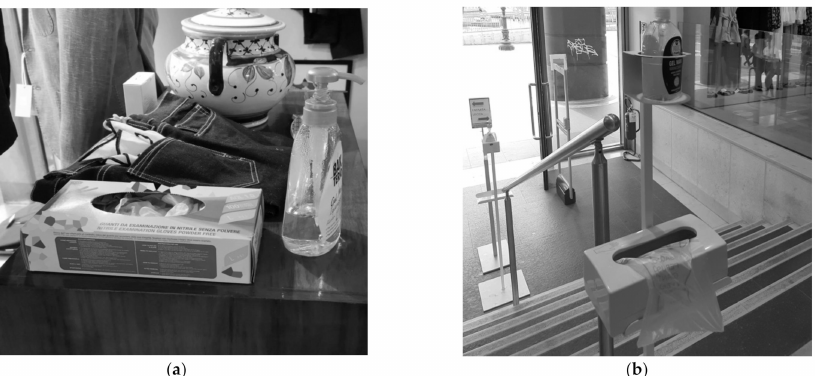
Figure A3. Images illustrating two examples of devices distributing gloves (C): one of them a simple box placed on a shop desk ( a ), while the other is integrated in a specific structure also including a hand-sanitizer dispenser ( b ).